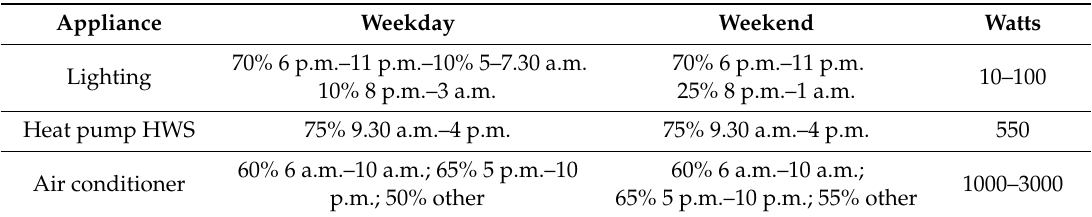
Table 2. Major load variations in spring / autumn. HWS—hot water system.